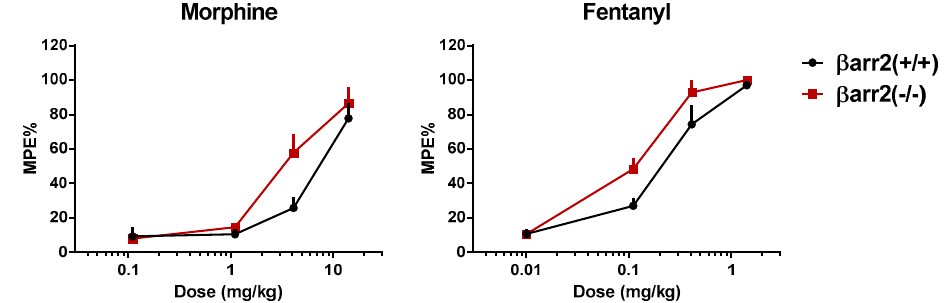
Figure 2. Mouse accumulated fecal boli assay. Dose response curves to morphine ( top panels) and fentanyl ( bottom panels) in β arr2(+/+) ( left panels) and β arr2( − / − ) ( right panels) mice. Data are mean ± SEM of 7 animals for each treatment. Experiments were performed as described in [24].